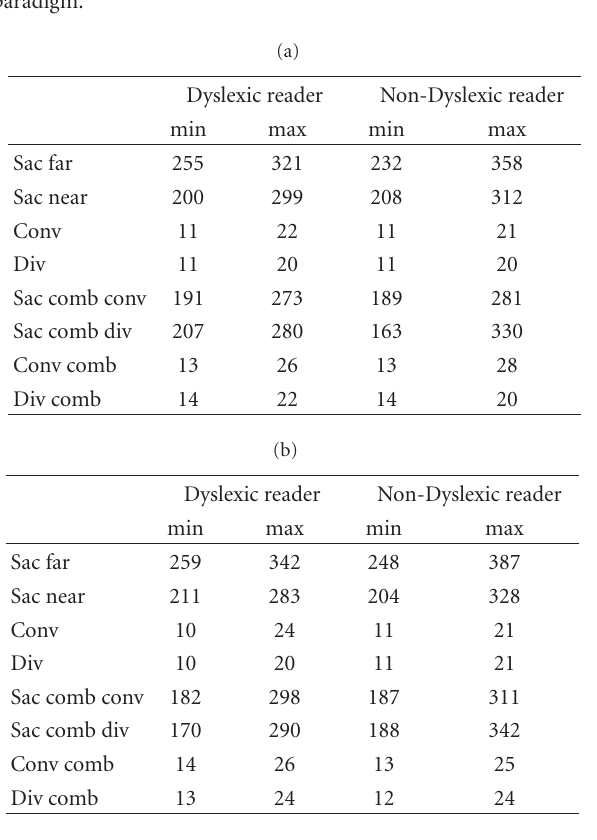
Table 2: Minimum and maximum mean velocity values for dyslexic and non-dyslexic reader children measured for each type of eye movements examined in the gap (a) and in the simultaneous (b) paradigm.